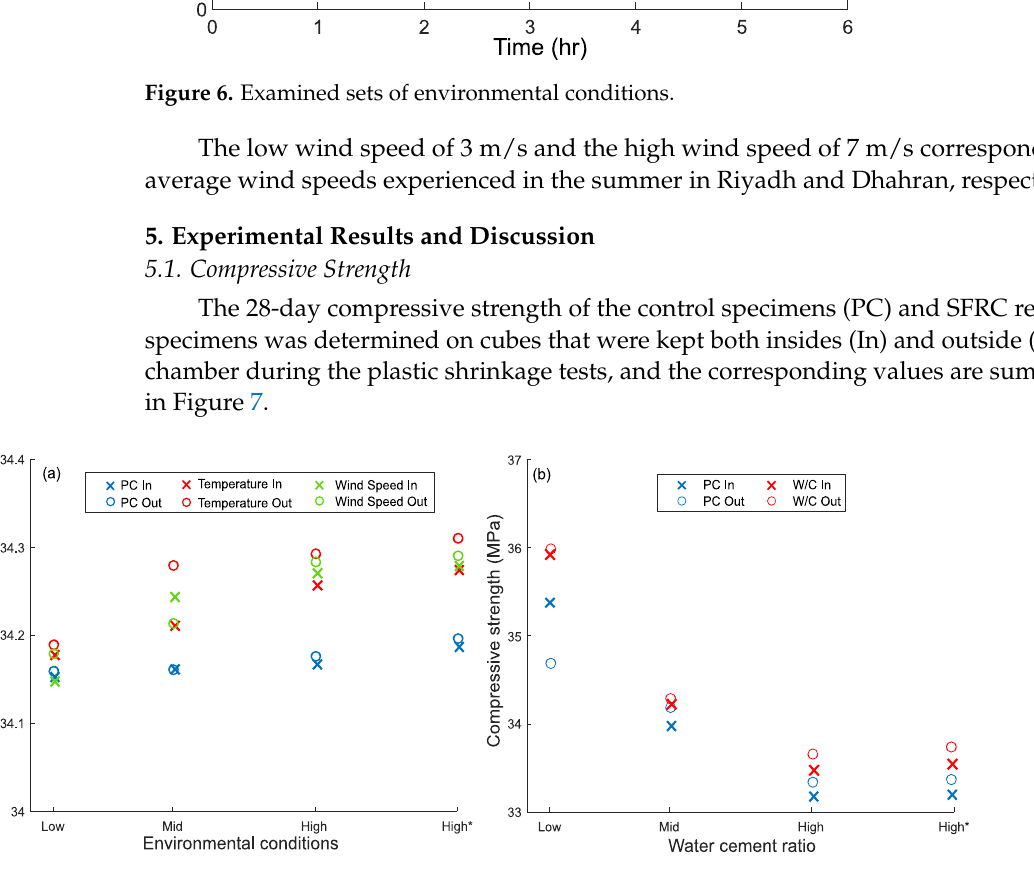
Figure 6. Examined sets of environmental conditions.